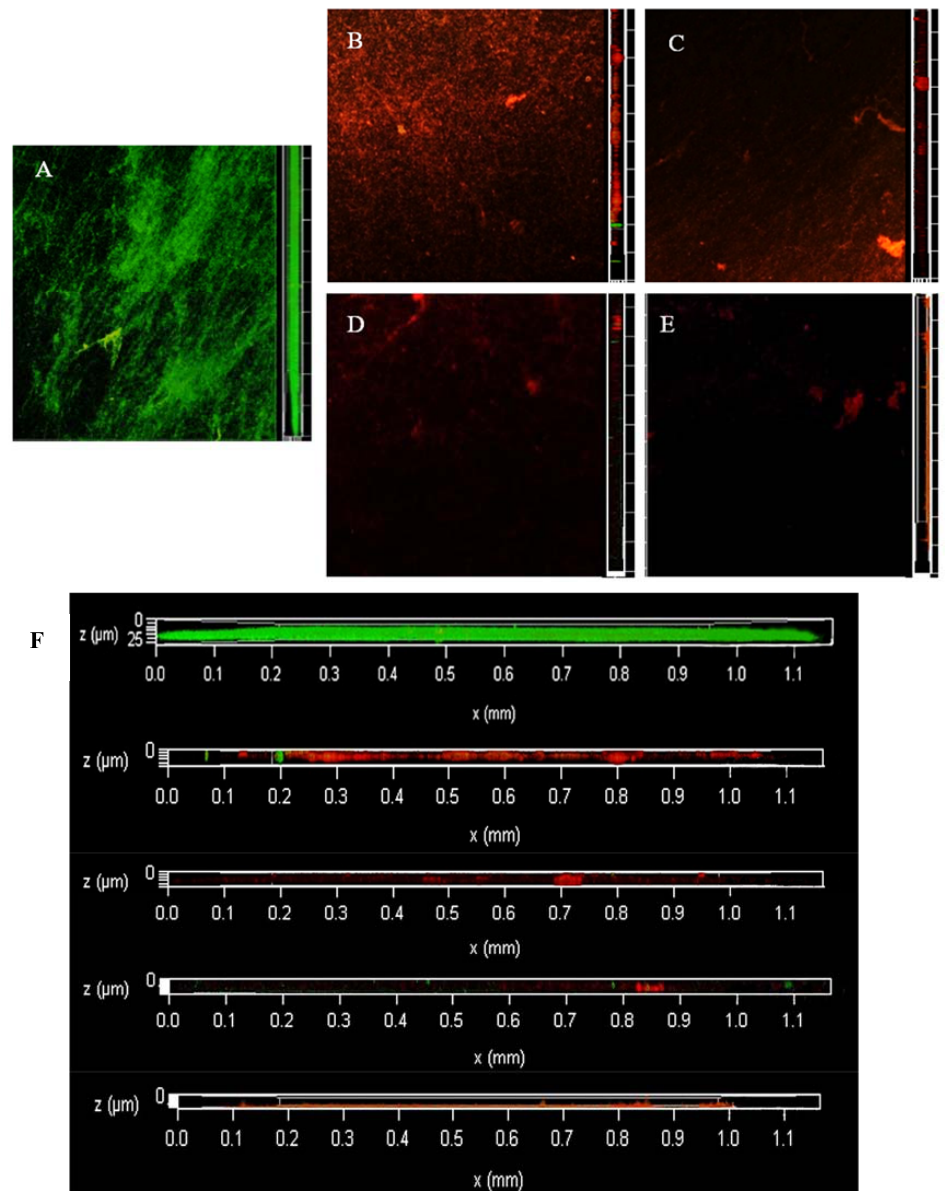
Figure 6. The changes of viable and dead colonies in LM biofilm after AEW and ALEW treatment observed by CLSM; each sample randomly selects three visual fields. Images include front and side views of the biofilm under CLSM. Scale bar—100 µ m. ( A ) is control, ( B ) is S 3 A 1 S 1 treatment, ( C ) is A 1 S 4 treatment, ( D ) is S 6 A 2 S 2 treatment, and ( E ) is A 2 S 8 treatment. ( F ) is an enlarged version of all the images on the right and is also a right-hand view of the biofilm, from top to bottom, for AEW and NEHW treatments 0, 2, 4, 6, 8 and 10 minutes respectively. Green—live cells, red—dead cells. AEW was acidic electrolytic water, and ALEW was alkaline electrolysed water.